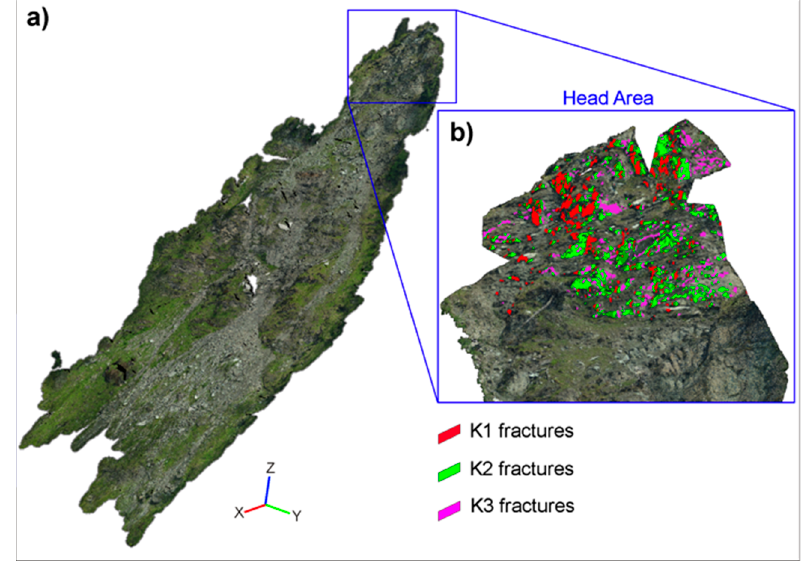
Figure 5. ( a ) 3D model of the Ingelsberg slope as a result of the processing of dense point clouds using SfM; and ( b ) 3D model of the Head Area of the Ingelsberg slope with planes extracted by the DSE software.